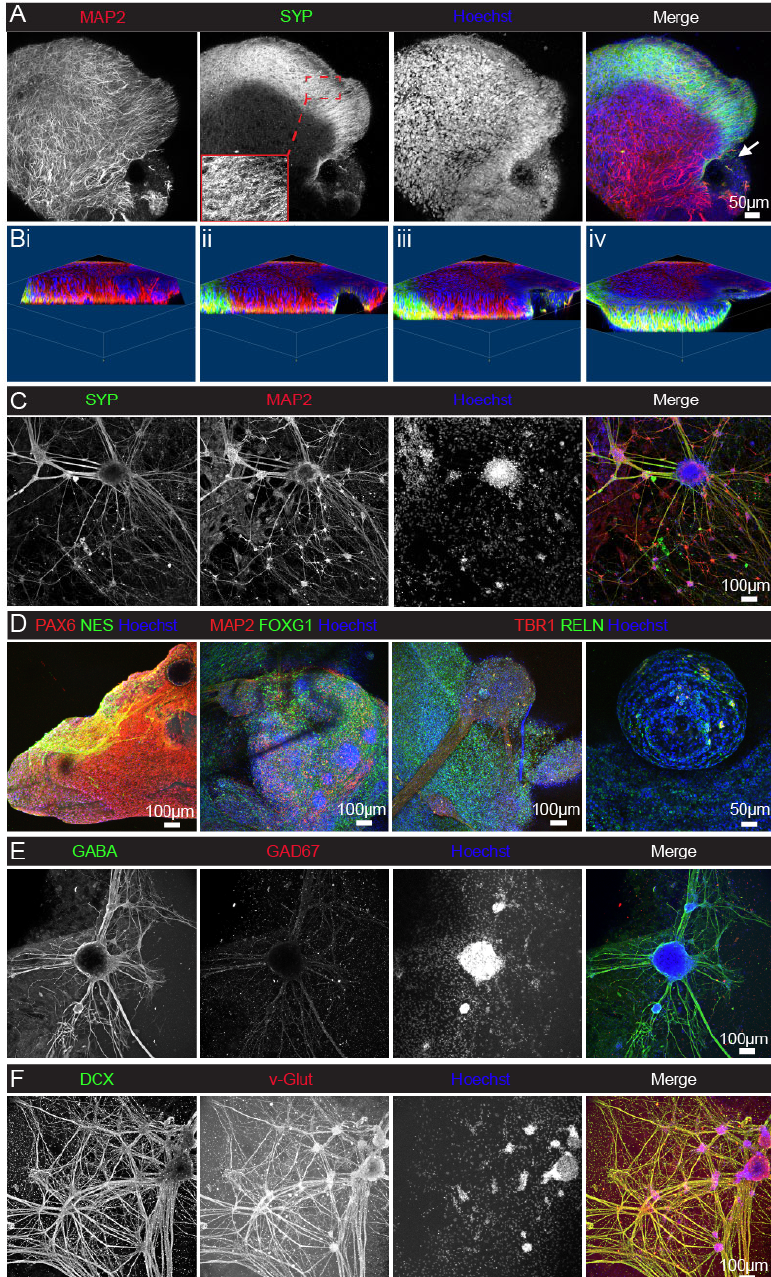
Figure 4. Cellular and regional heterogeneity of 53-day old brain organoids. ( A ): A 53-day old organoid (4 days iPSC expansion + 7 days neural induction + 42 days neural differentiation) with a tuboid structure (arrow), abundant MAP2-labelled processes, and demarked synaptophysin expression (with synaptic puncta evident in the magnified inset). ( B ): 3D visualization of orthoslice images at (i) 280 µ m, (ii) 440 µ m, (iii) 540 µ m, and (iv) 760 µ m from edge of organoid depicted in ( A ). ( C ): MAP2 partially colocalised with synaptophysin expression, recurrently signifying regions of neuronal networking within organoids and between networks of organoids connected by long-projecting neurite bundles. ( D ): PAX6 and FOXG1 expression, together with cortical plate (TBR1) marker expression more specifically evidencing dorsal forebrain identity, with RELN and NES expression indicative of cortical tissue-like neuronal layer formation and a persistent neural progenitor cell population, respectively. ( E , F ): GABA, GAD67, v-Glut, and cortical neuronal marker DCX expression of organoid networks. Pseudocoloured images as indicated by colour of text. Scale bars as